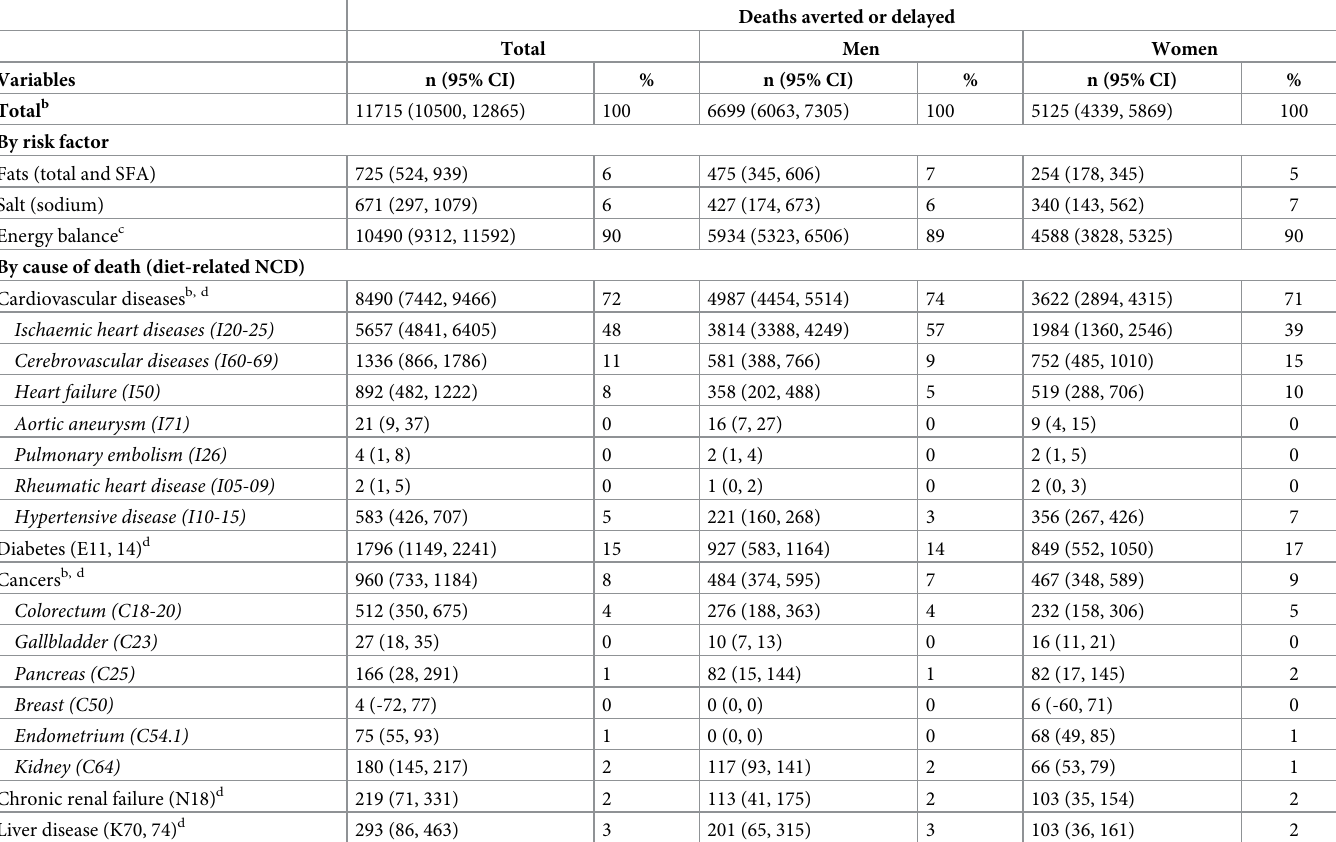
Table 1. Estimated number of deaths prevented per year under the traffic light labelling scenario, by diet-related risk factor and by cause a